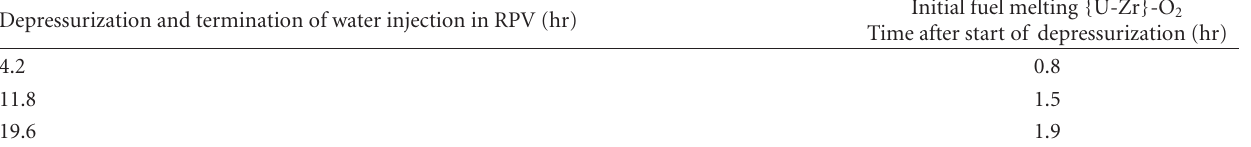
Table 2: Timing of initial fuel melting for scenarios with depressurization and termination of emergency water injection at 4.2, 11.8, and 19.6 hours after reactor scram (CRD flows